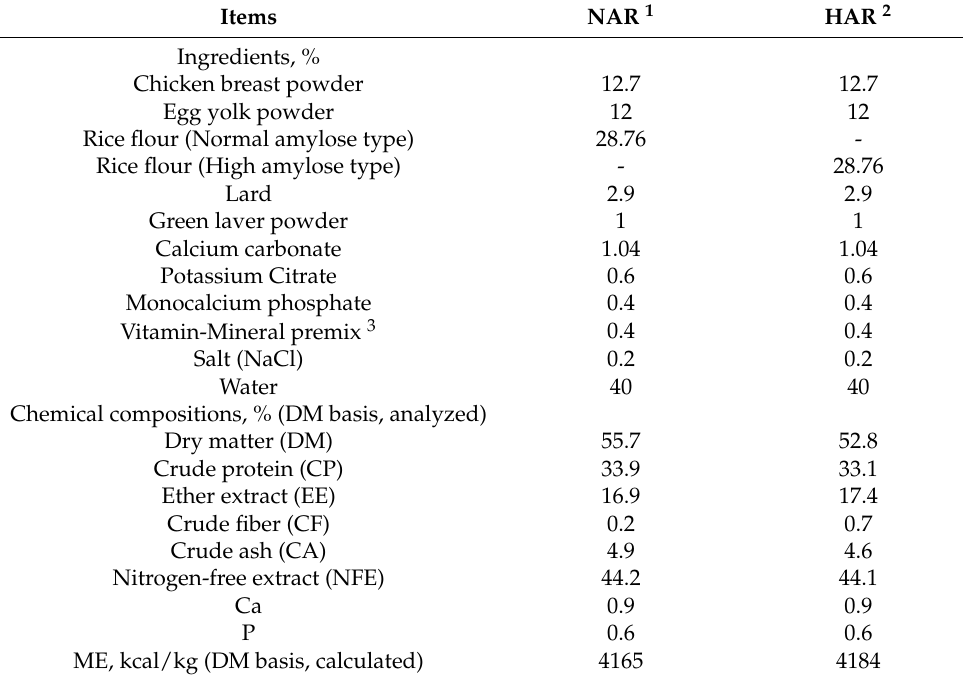
Table 2. Formulation and chemical composition of experimental diets (Exp.